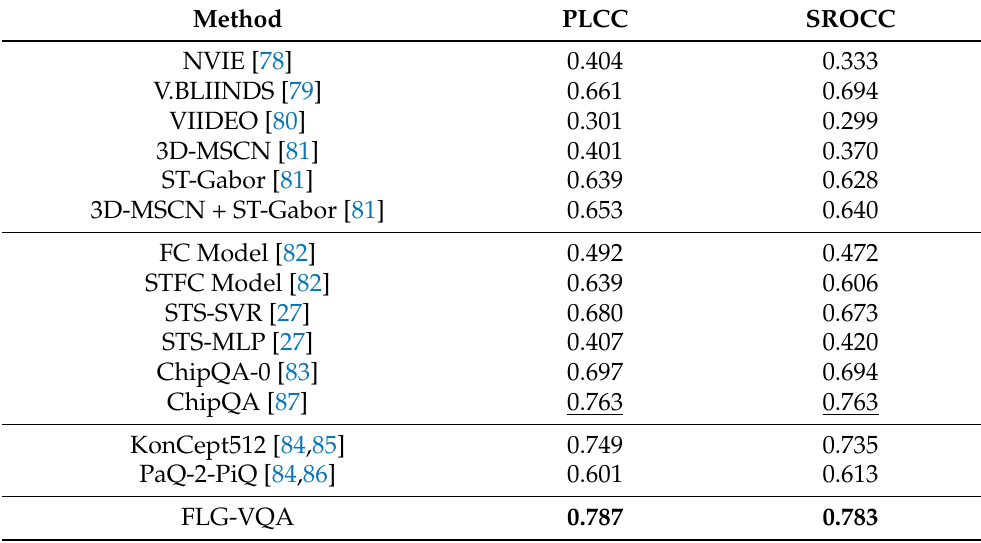
Table 3. Comparison of FLG-VQA with the state-of-the-art methods on KoNViD-1k [16]. The median PLCC and SROCC values were measured over 1000 random training–testing splits. The best results are in bold, while the second-best results are